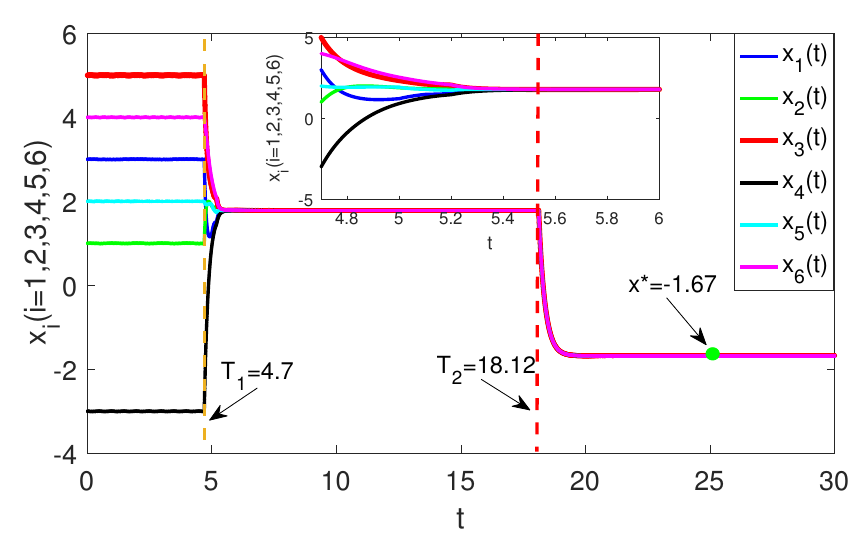
Figure 7. The states of x i ( t ) for i = 1,2, · · ·